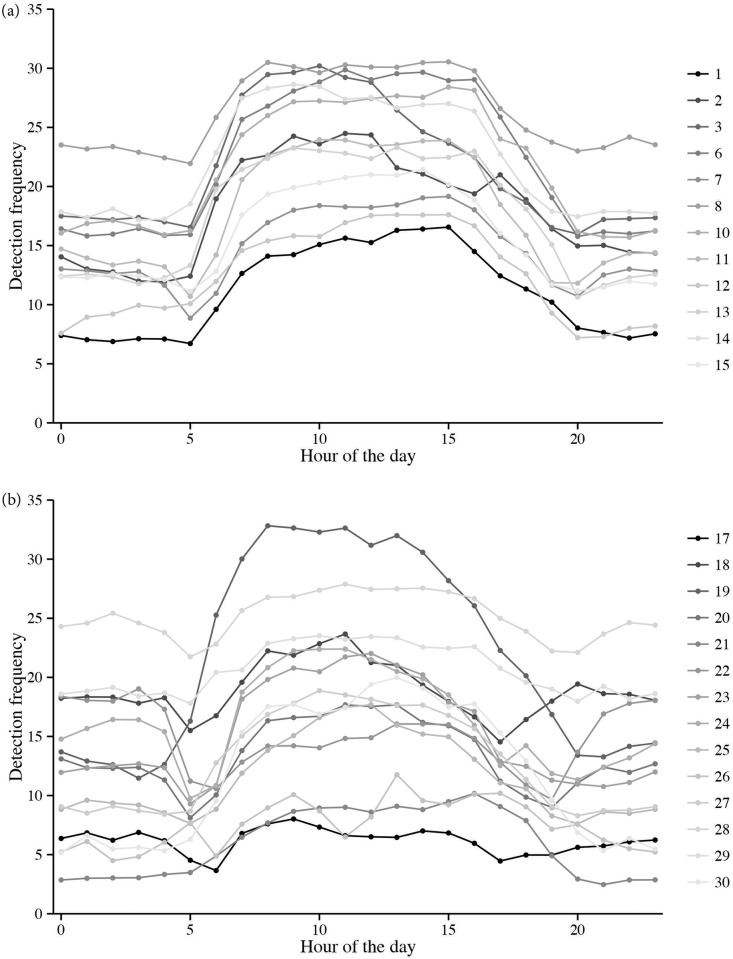
Diel activity patterns of tagged Chrysophrys auratus.a-b indicate the maturity stage of the tagged fish: a = juvenile; b = adult. Hour of the day is represented by a 24 hour clock.